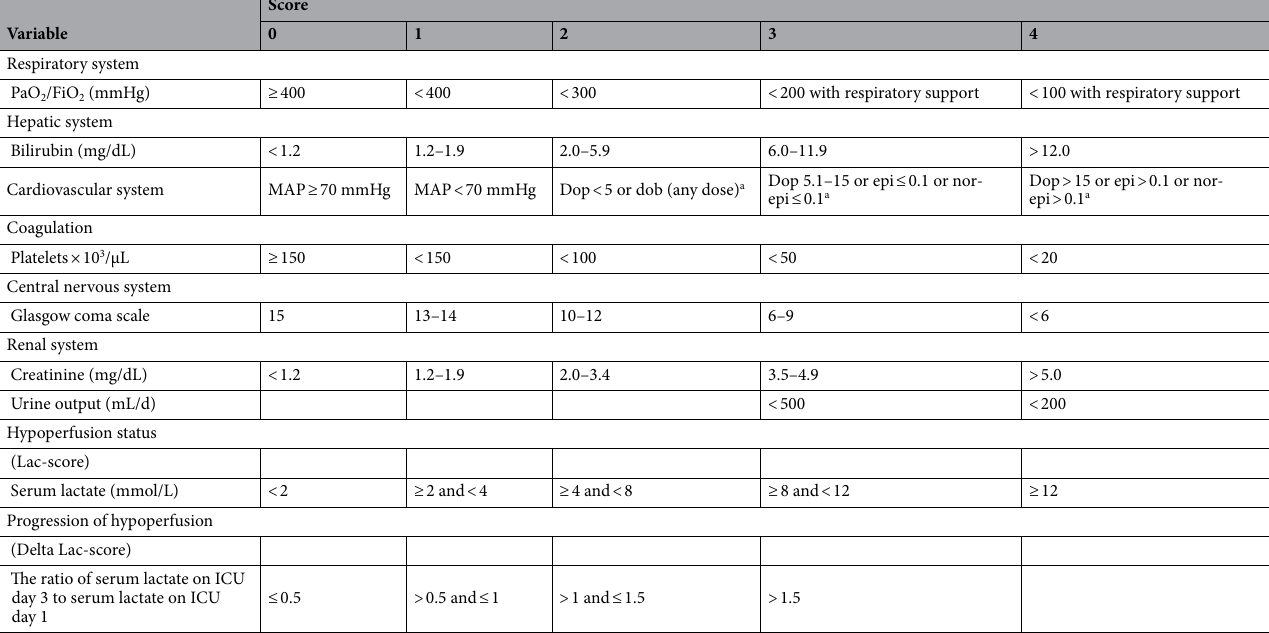
Table 1. Sequential Organ Failure Assessment (SOFA) score with the Lac-score and Delta Lac-score. a Adrenergic agents administered for at least 1 h, all catecholamine doses represent µg/kg/min; Lac-SOFA score was defined as sum of Lac-score and SOFA score. Delta Lac-SOFA was defined as sum of Lac-SOFA ICU day-3 and Delta Lac-score. ICU intensive care unit, PaO 2 partial pressure of oxygen, FiO 2 fraction of inspired